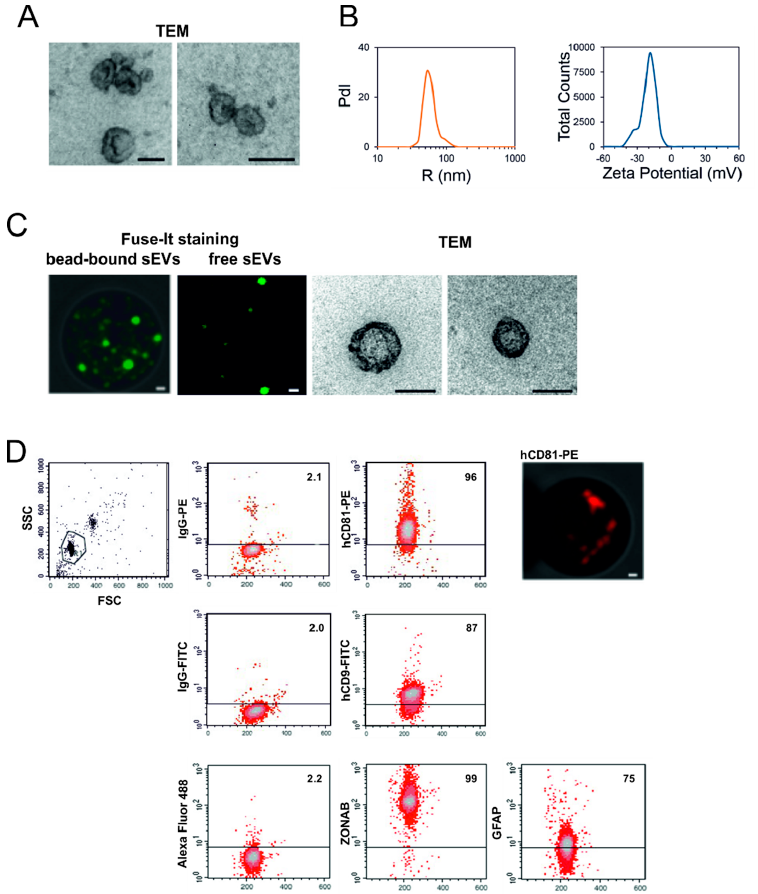
Figure 2. Characterization of M14-released tumor-secreted small extracellular vesicles (sEVs) in cell culture. ( A ) Morphological examination of small extracellular vesicles (sEVs) purified from M14 cell culture medium was performed by transmission electron microscopy (TEM). Bars, 100 nm. ( B ) Size and number of the released sEVs was measured by dynamic light scattering. The representative Intensity distribution curve and Zeta potential distribution are an average of five different measurements of the same sample. ( C ) sEVs purified from cell culture were immunocaptured by magnetic Dynabeads conjugated with CD63 tetraspanin. The bead-bound sEVs stained by Fuse-It membrane-specific dye were studied by confocal microscopy (left panel, bars, 500 nm). The stained sEVs were then detached from the beads and analysed by confocal microscopy (middle panel, bars, 500 nm) and by TEM (right panels, bars, 100 nm). ( D ) Bead-bound sEVs were processed for the detection of the indicated molecules by immunofluorescence and flow cytometry. Aggregates and debris were excluded (gating) from the fluorescence analysis, as shown in the cytogram relative to the light scatter parameters (left panel, top). In each cytogram the number reported represents the percentage of positivity for the indicated molecule. As an example, right top panel reported the confocal microscopy of bead-bound sEVs stained with anti-CD81 antibody conjugated with phycoerythrin (PE). Bar, 500 nm. PdI, intensity distribution; SSC, side scatter; FSC, forward side scatter; FITC, fluorescein isothiocyanate; ZONAB, ZO-1-associated nucleic acid-binding protein; GFAP, glial fibrillary acidic